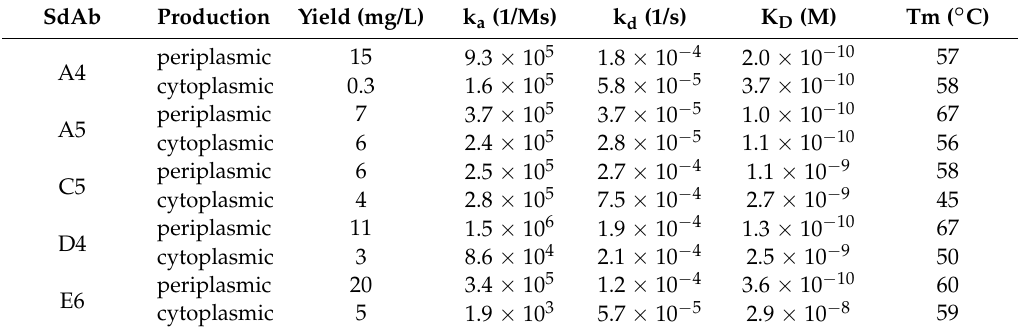
Table 1. Single-domain antibody (sdAb) properties: yields, binding kinetics, affinity, and melting temperature (Tm).